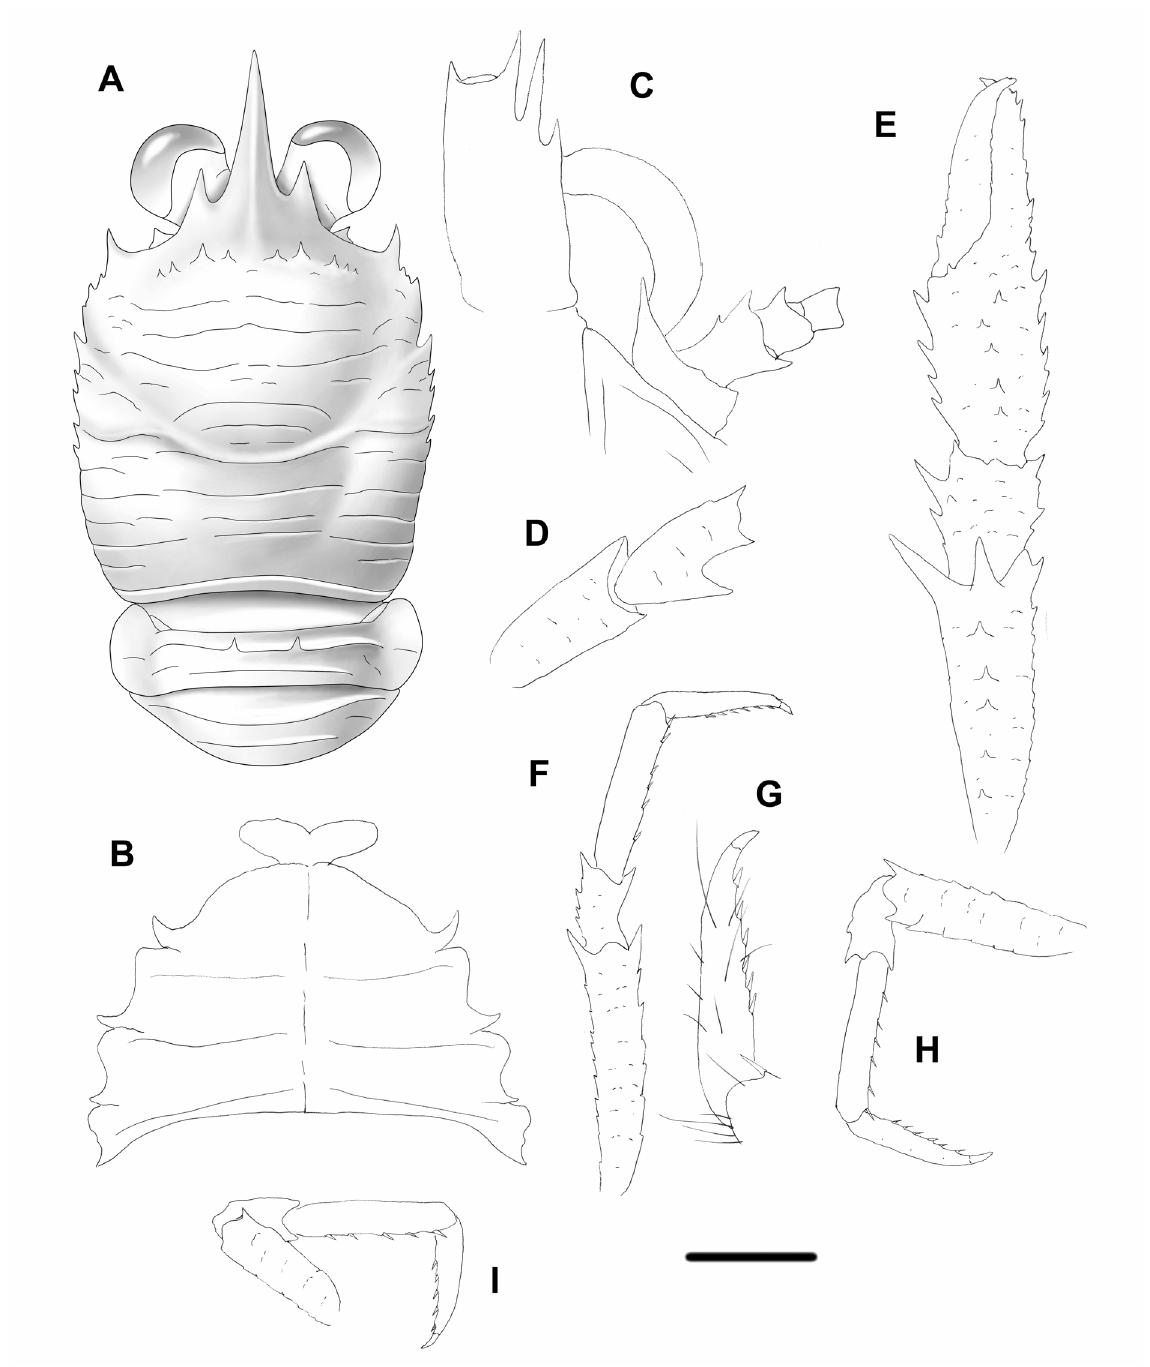
Fig. 8. Munida stomifera sp. nov., holotype, ♀, 2.8 mm (MNHN-IU-2014-13473), Madagascar. A . Carapace and abdomen, dorsal view. B . Sternal plastron. C . Cephalic region, showing antennular and antennal peduncles, ventral view. D . Right Mxp3, lateral view. E . Right P1, dorsal view. F . Right P2, lateral view. G . Dactylus of right P2, lateral view. H . Left P3, lateral view. I . Right P4, lateral view. Scale bar: A, E–F, H–I = 1.0 mm; B–D, G = 0.5